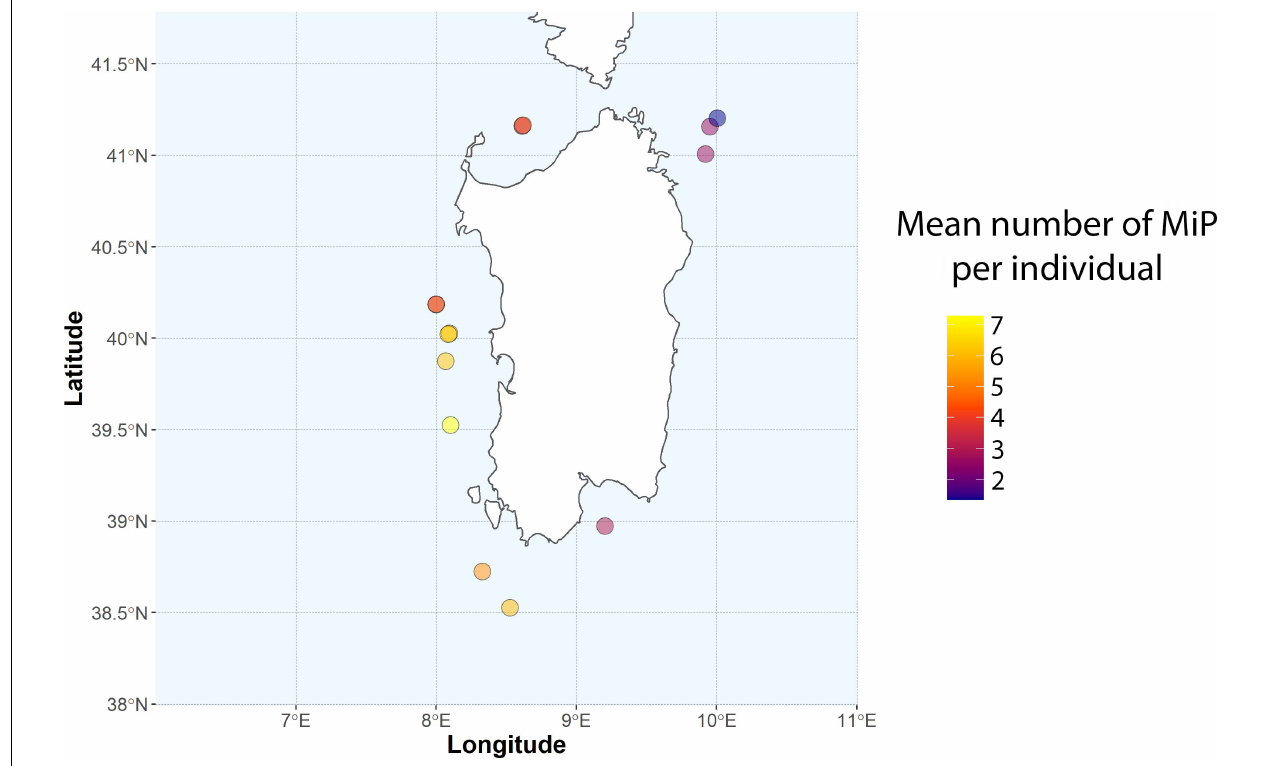
FIGURE 2 | Mean number of MiP per individual for each sampling